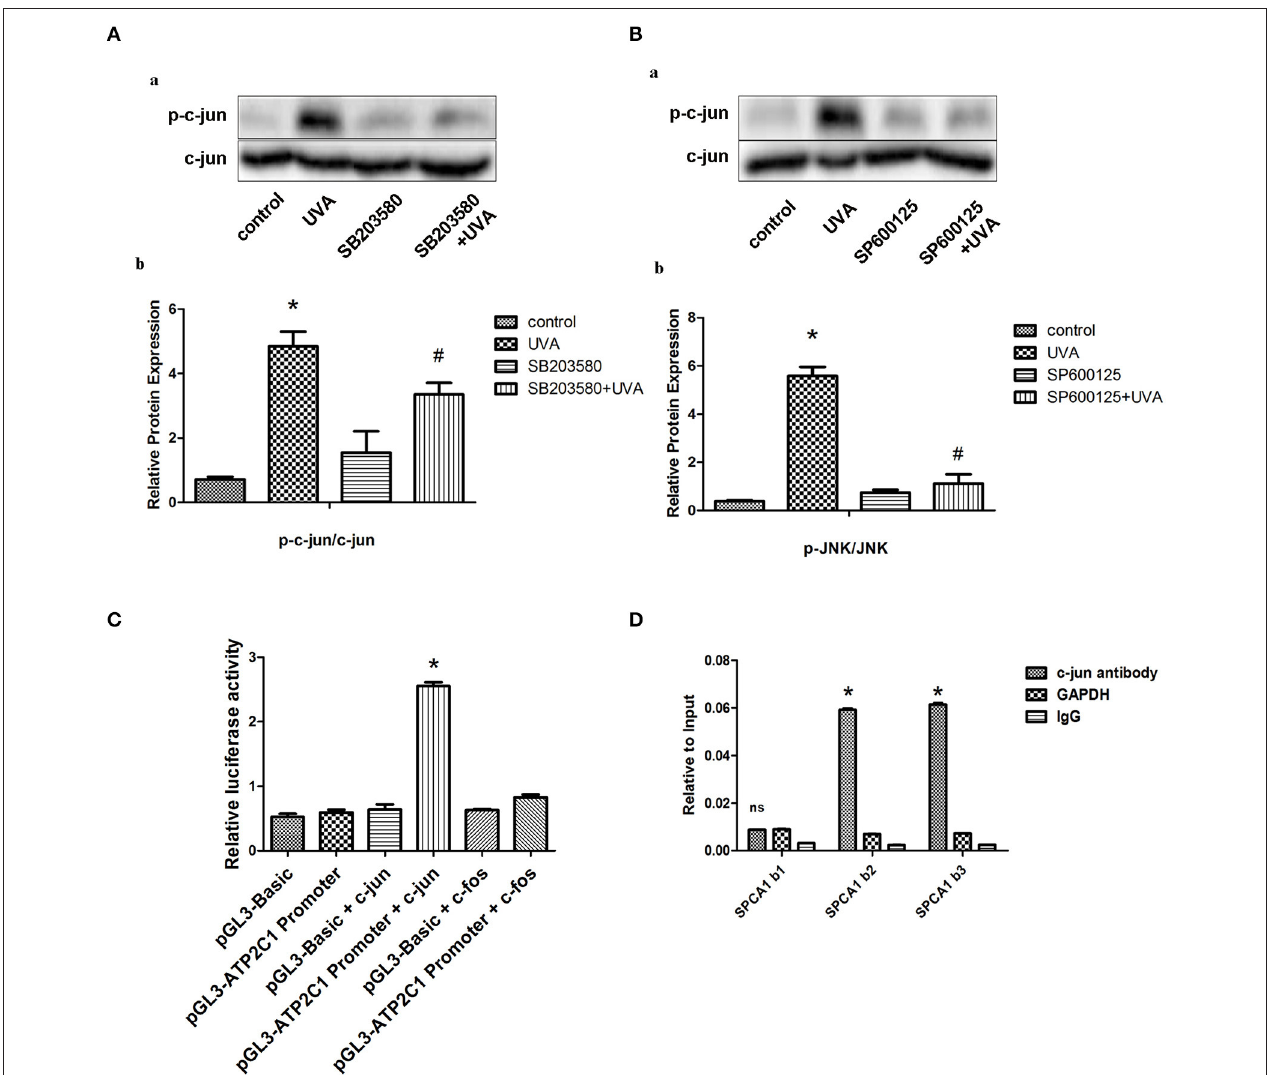
FIGURE 2 | MAPK transcriptionally regulates SPCA1 via activating c-jun. (A,B) Western blot images and quantitative analysis show effects of SB203580 and SP600125 on UVA-induced phosphorylation of c-jun. Images are representative of three independent experiments. * P < 0.05 vs. control; # P < 0.05 vs. SB203580 + UVA or SP600125 + UVA. The treatment of SB203580 and SP600125 is described above. (C) Luciferase reporter assay data, showing the activity of SPCA1 promoter. Cells were transfected with the following plasmids: c-jun, c-jun-cDNA-expressing vector; c-fos, c-fos-cDNA-expressing vector; ATP2C1, reporter plasmid containing SPCA1 promoter. Experiments were performed in triplicate. * P < 0.05 vs. pGL3-ATP2C1 promoter. (D) Chromatin immunoprecipitation data from HDFs incubated with either anti-SPCA1 antibody or non-specific control IgG, showing the amplification of each of the four predicted c-jun-binding sites within the SPCA1 promoter (termed SPCA1 b1, b2, and b3). Experiments were performed in triplicate.* P < 0.05 vs. IgG; ns P < 0.05 vs. IgG.